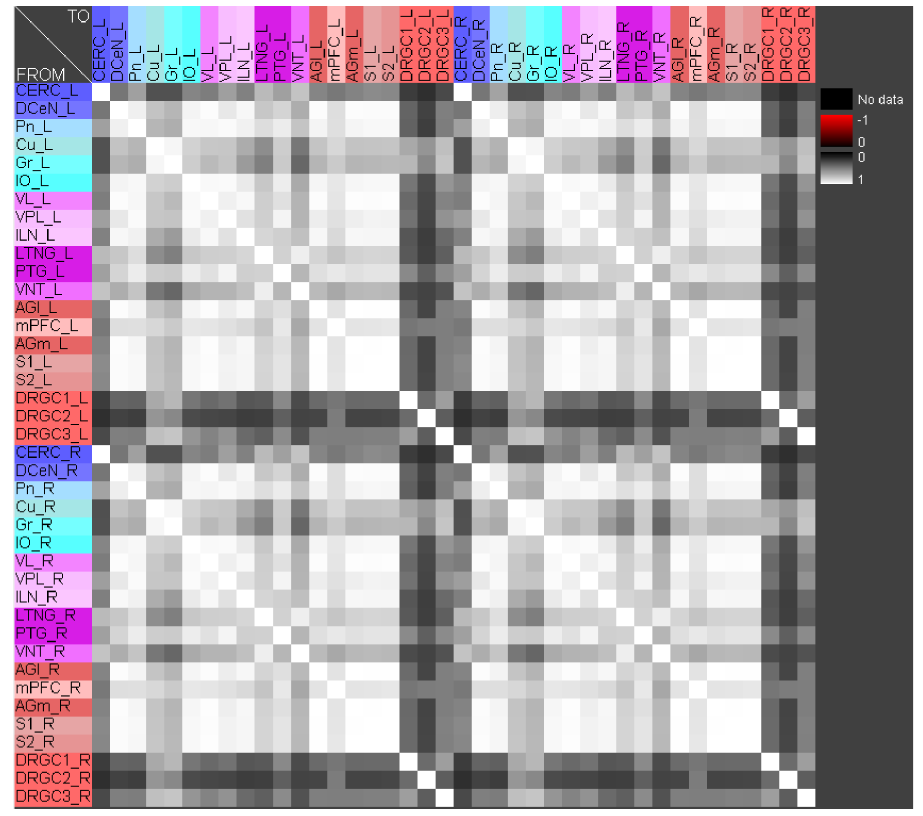
Fig 5. Average cross-correlation matrix of four parameters of the GM model. The average cross-correlation matrix of the variation of the four reaction constants is shown. This matrix has been used for further cluster analysis.